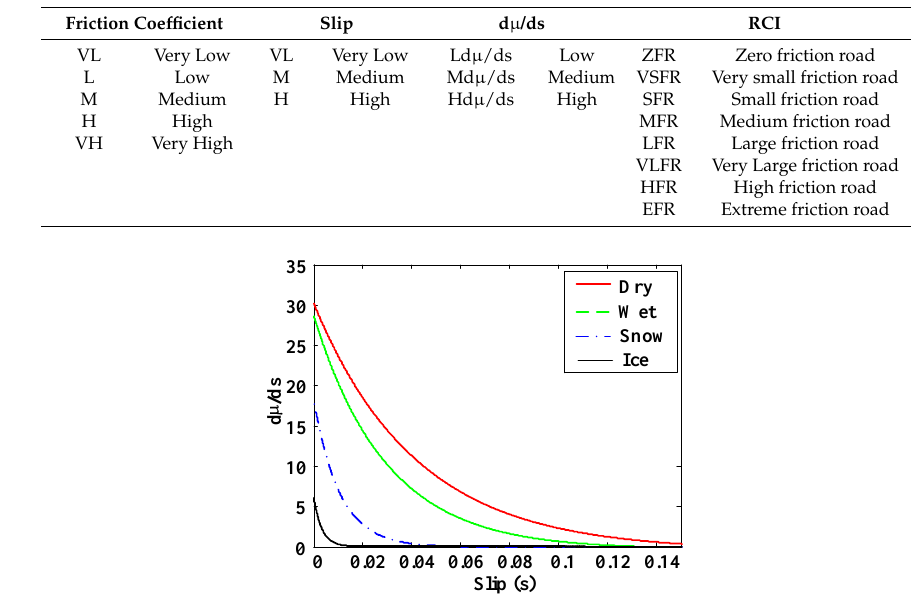
Figure 5. dµ/ds vs. s curves for different surfaces. Figure 5. d µ /ds vs. s curves for different